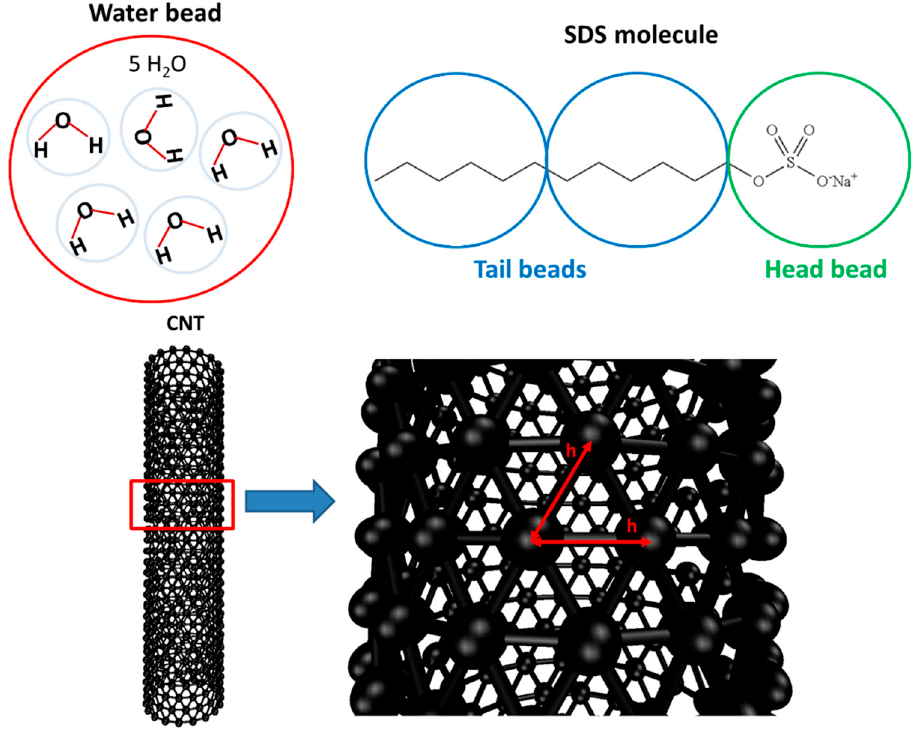
Figure 9. A schematic representation of the coarse-grained model for water, SDS surfactant molecule, and CNT in our DPD simulation. Each water bead represents five water molecules. The SDS molecule has three beads, including one head and two tail beads. For the CNT, the distance (h) between two nearest beads is 0.5 r c .